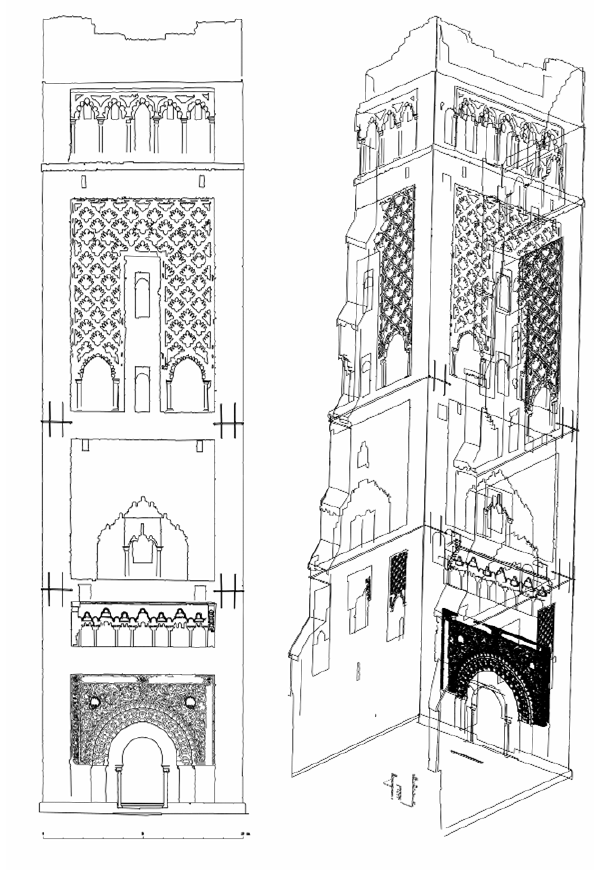
Figure 9. Elevation and 3D model of the minaret of Mansura